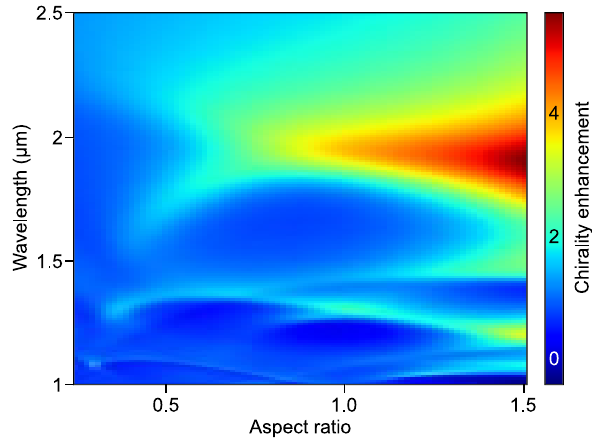
Figure 5: Orientation averaged chirality enhancement as a function of  obtained using the T-matrix method. In this scenario, chirality is enhanced predominantly by dipole modes with maximal enhancements observed for particles with large aspect ratios.